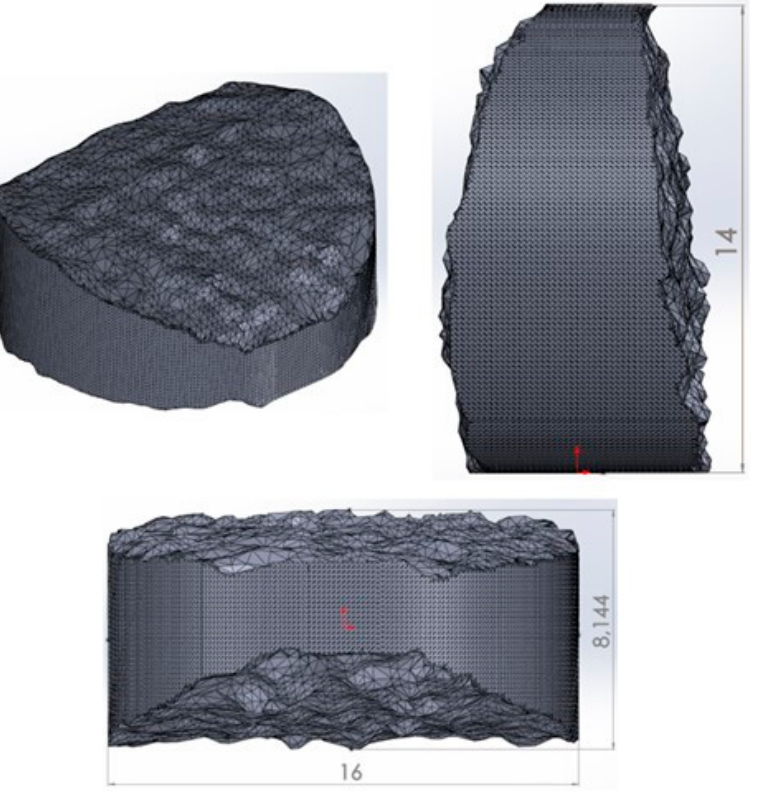
Figure 5. CAD model of the implant of the intervertebral disc (height, width, and thickness of the model).